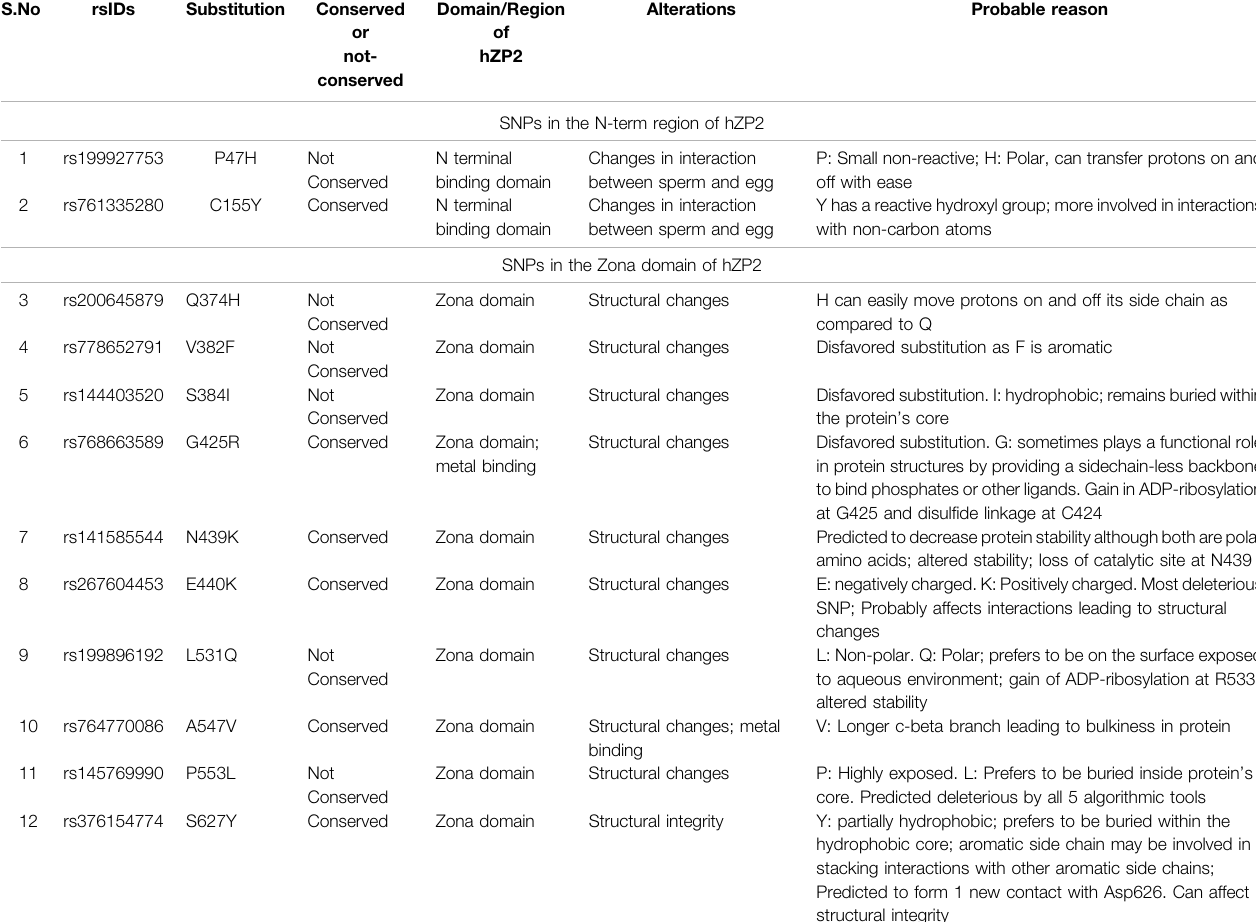
TABLE 7 | Summary of the properties of shortlisted deleterious nsSNPs and their effect.